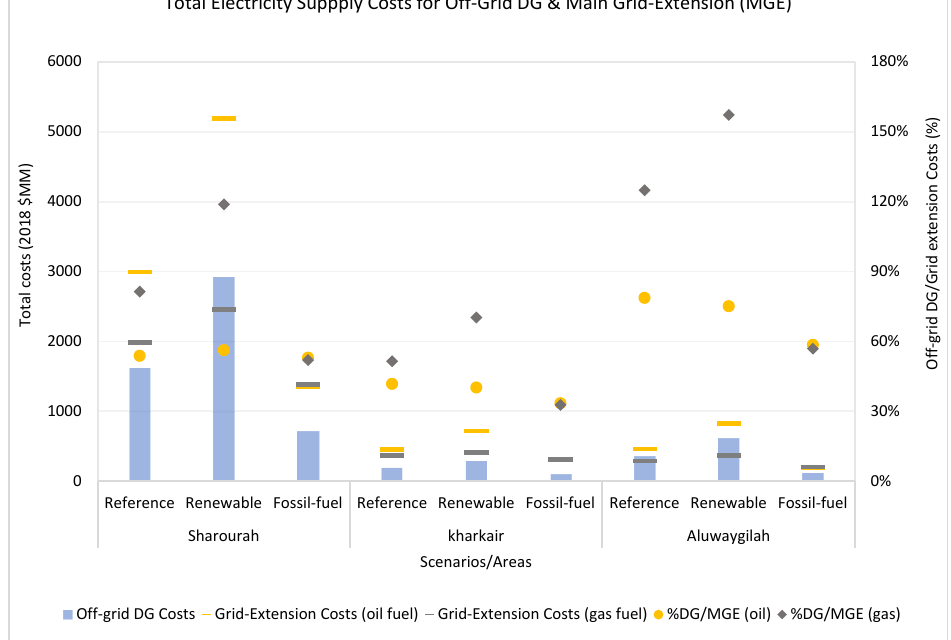
Figure 1. Total costs of supplying electricity to the remote areas by either off-grid DG or the main-grid extension (fueled by oil or gas) under all scenarios. The yellow circles and gray diamonds indicate the cost ratio of off-grid DG to the primary grid extension fueled by oil and gas, respectively. In Figure 1, the yellow circles represent the cost ratio (%) of off-grid DG to MGE-oil (i.e., assuming the primary grid is powered by an oil-fired CCPP). The gray diamonds